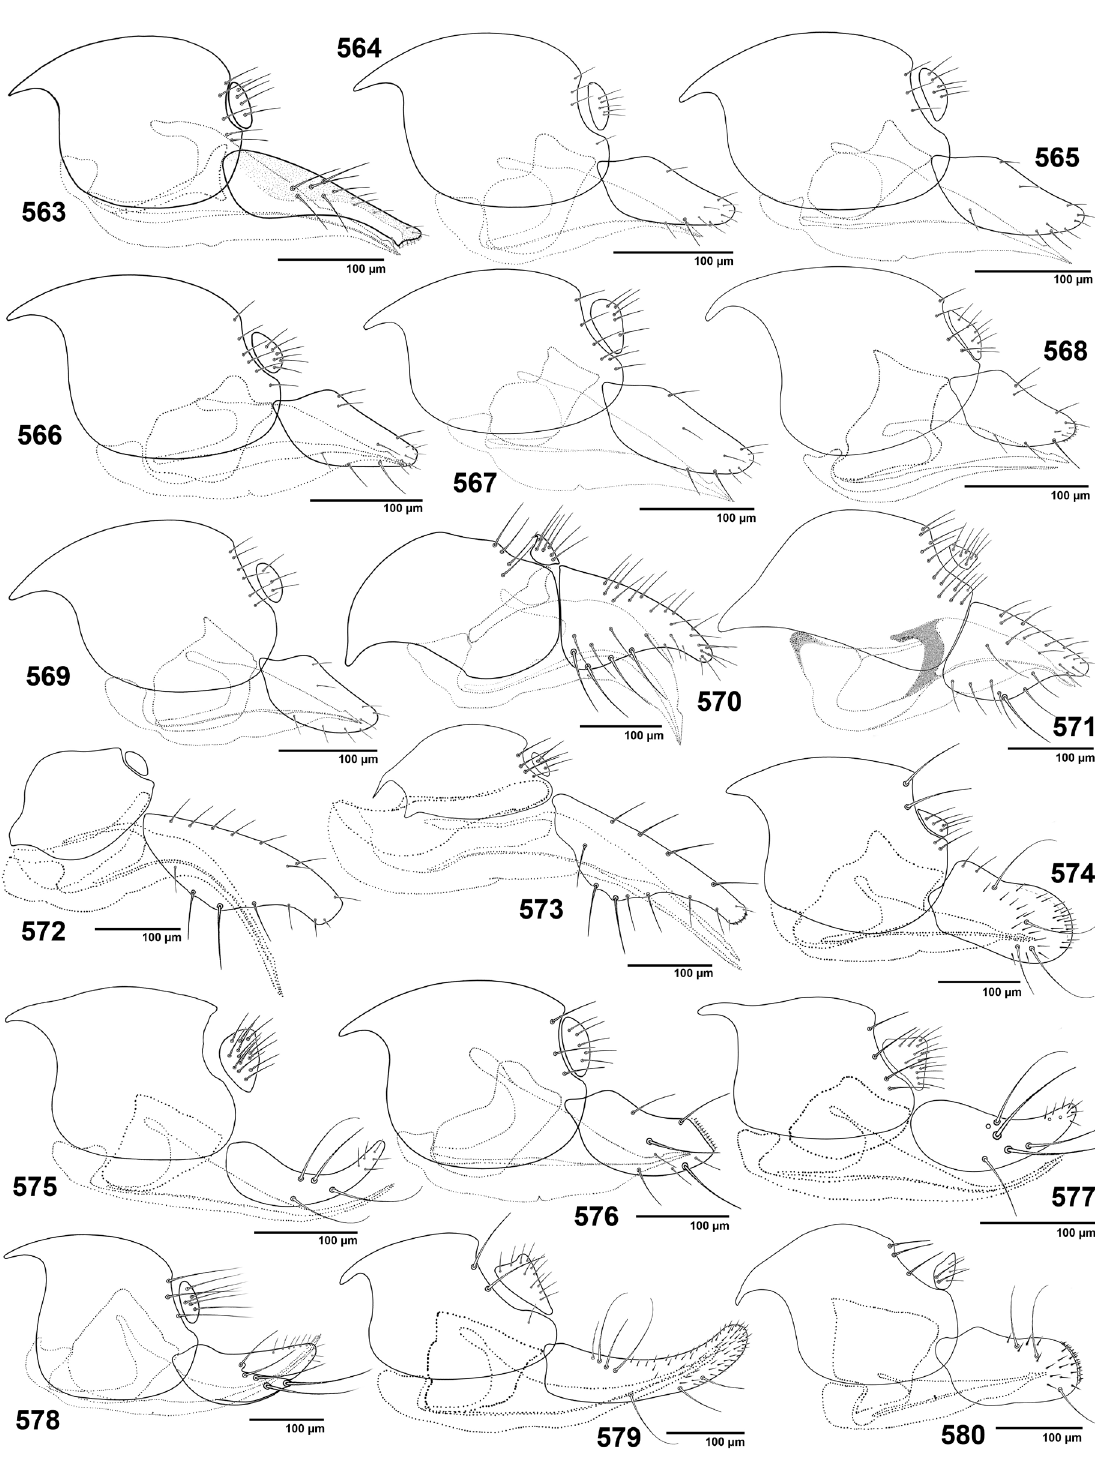
Figs 563–580. Lateral aspect of ♀ genitalia: 563 . Lipolexis gracilis . 564 . Lysiphlebus cardui . 565 . Lysiphlebus confusus . 566 . Lysiphlebus desertorum . 567 . Lysiphlebus fabarum . 568 . Lysiphlebus fritzmuelleri . 569 . Lysiphlebus testaceipes . 570 . Monoctonia pistaciaecola . 571 . Monoctonia vesicarii . 572 . Monoctonus crepidis . 573 . Monoctonus mali . 574 . Pauesia abietis . 575 . Pauesia anatolica . 576 . Pauesia antennata . 577 . Pauesia cedrobii . 578 . Pauesia hazratbalensis . 579 . Pauesia picta . 580 . Pauesia pini